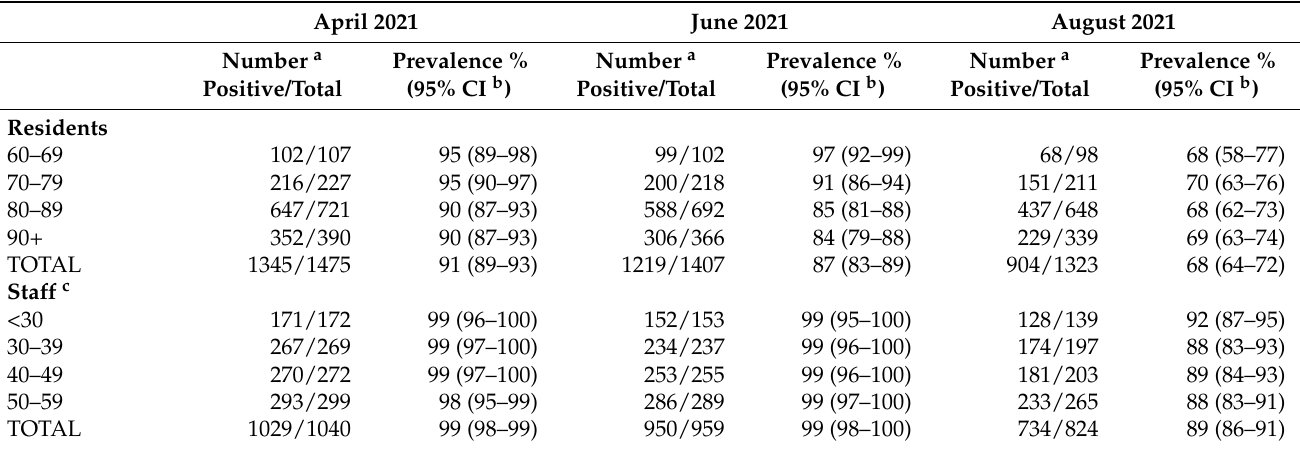
Table 1. Number and adjusted prevalence of SARS-CoV-2 antibodies among residents and staff in Belgian nursing homes per age group, two (April 2021), four (June 2021) and six months (August 2021) after COVID-19 vaccination.